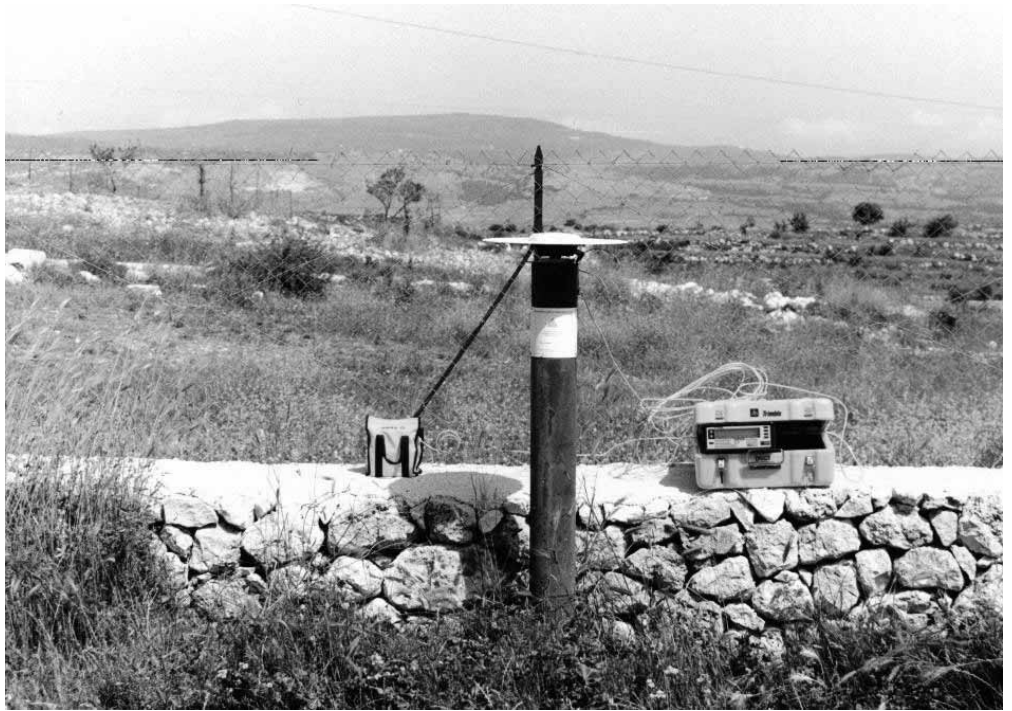
Fig. 3. Typical station of the Hyblean GPS network (IP21 pillar).